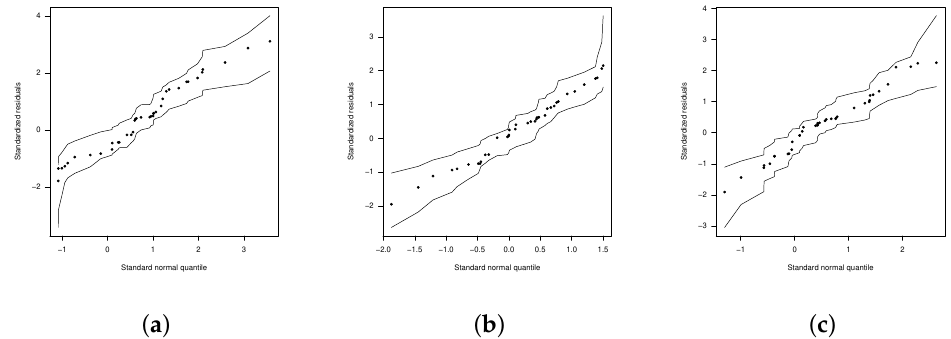
Figure 1. Envelope graphs for r MT